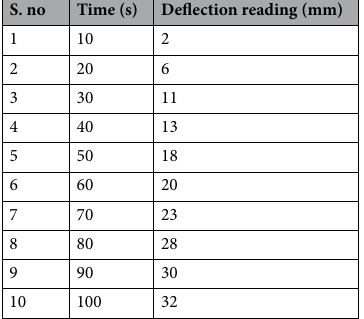
Table 2. Deflection response of the SA/SPVA-PANI-Pt membrane with applied voltage of 3 V.